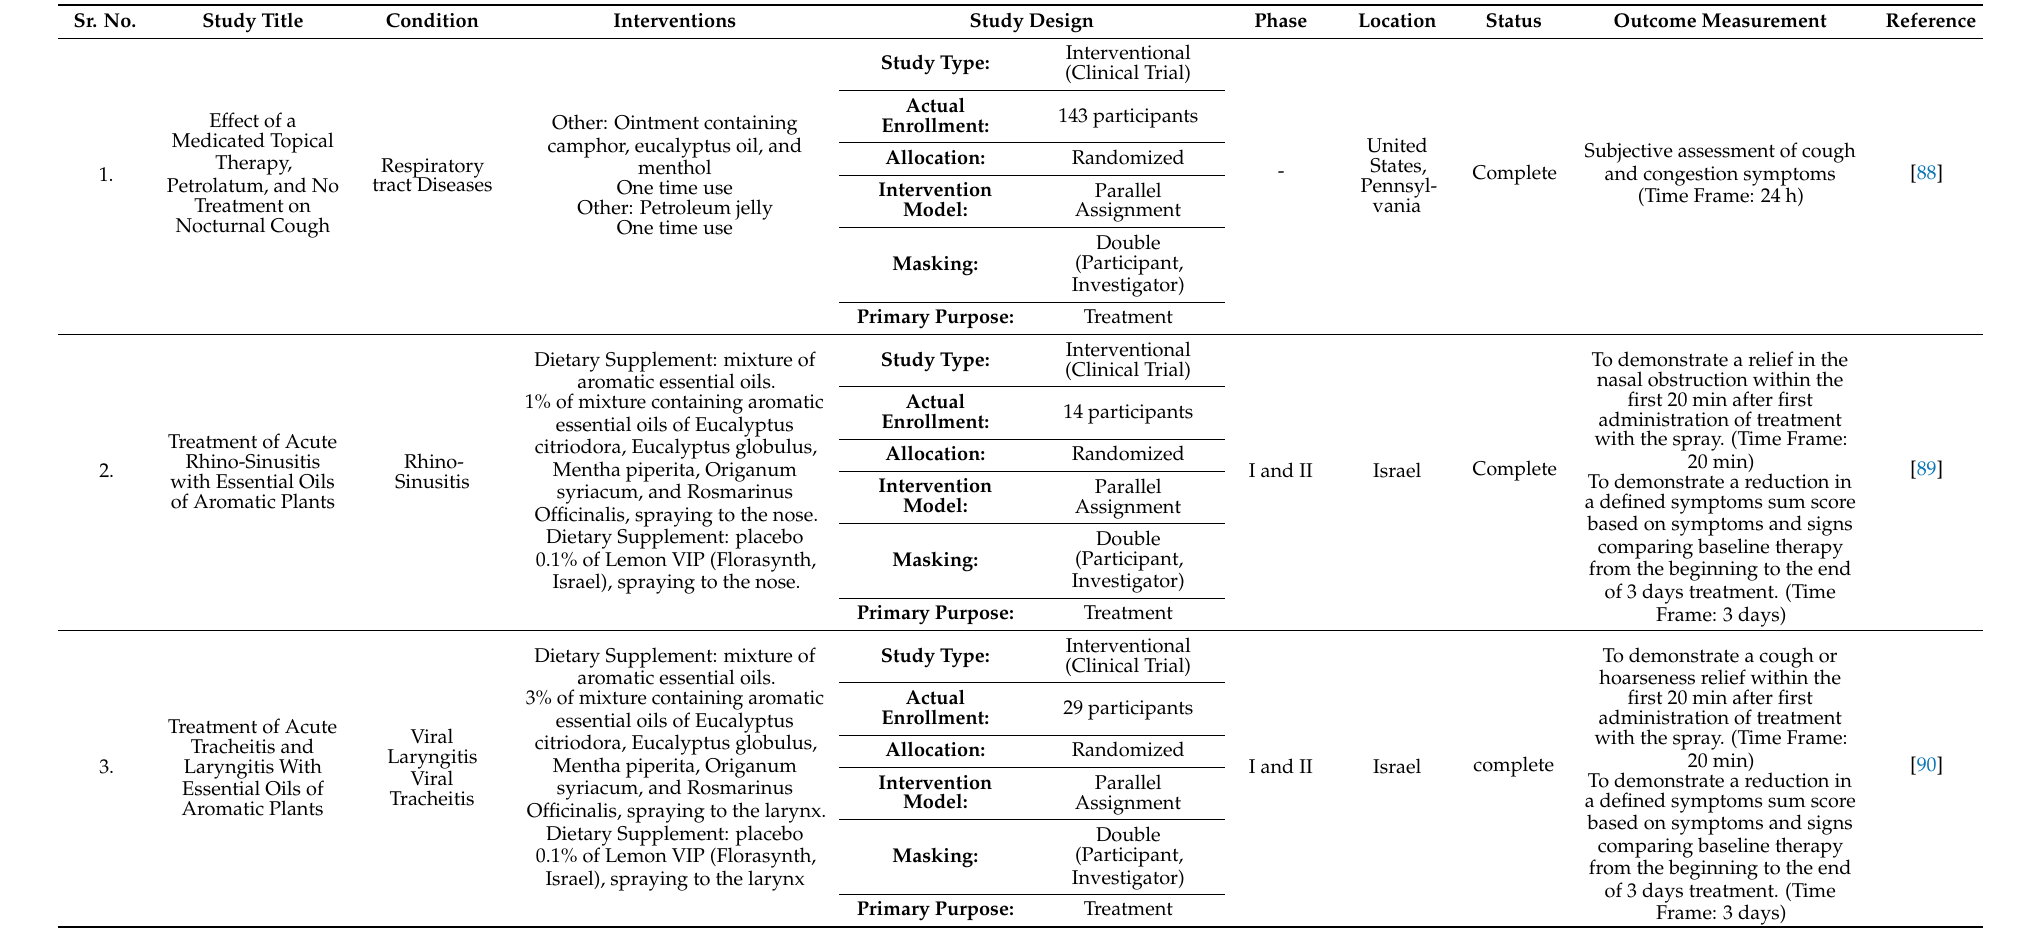
Table 3. Clinical trial data of some Essential